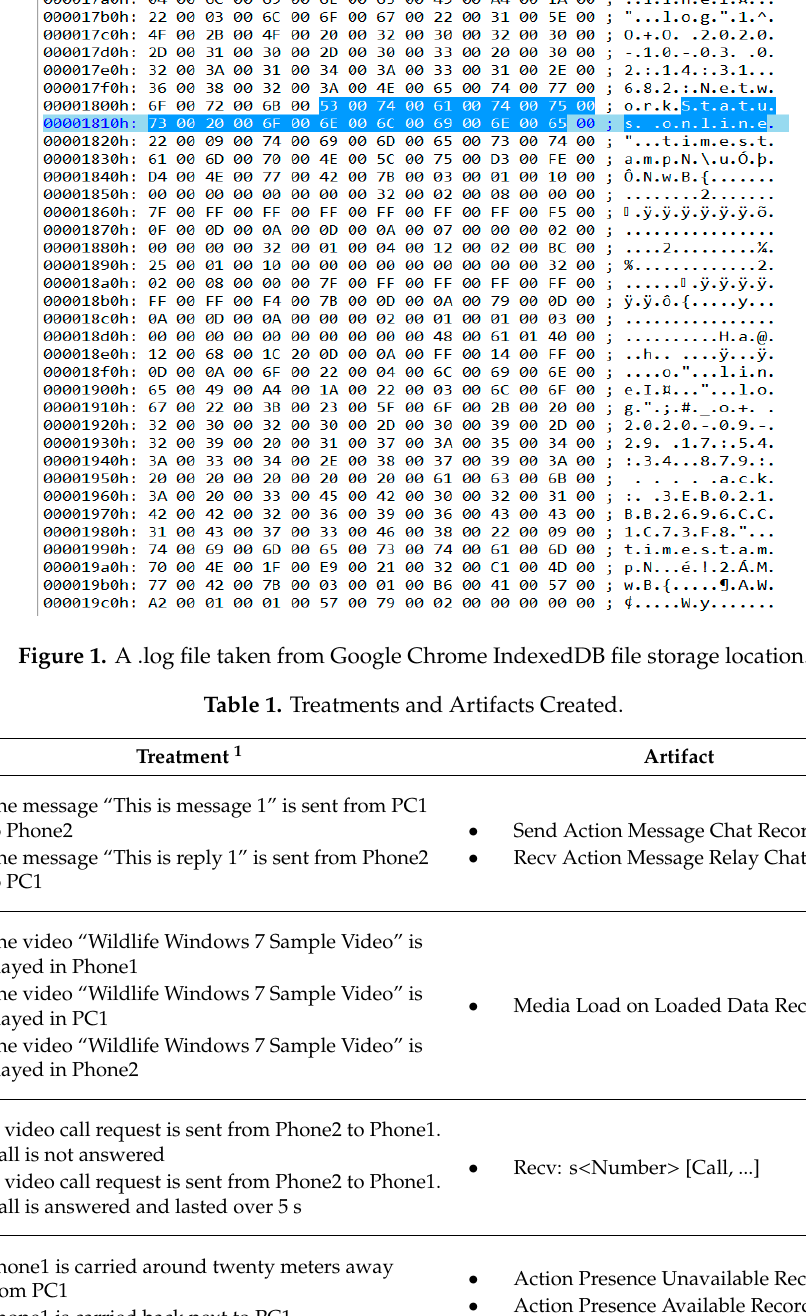
Table 1. Treatments and Artifacts Created.